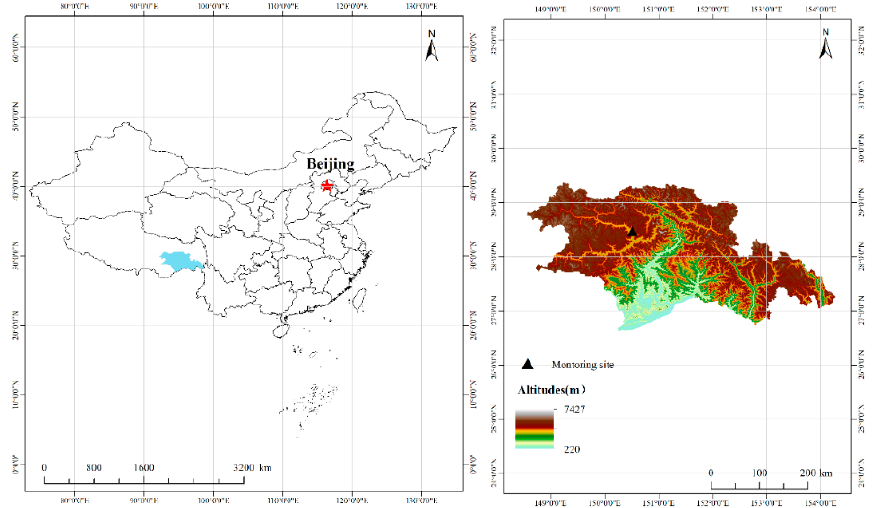
Figure 1. Location of the monitoring site.